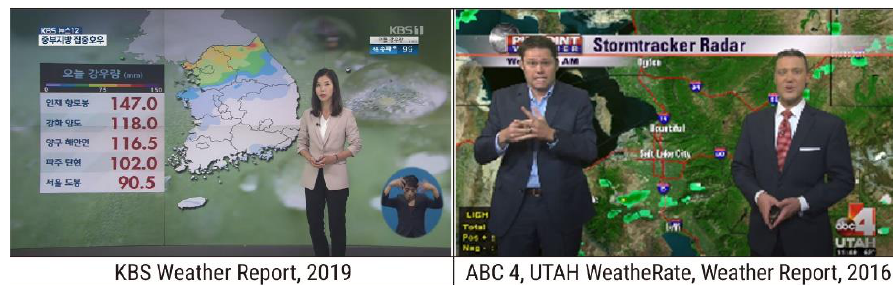
Figure 8. Examples of sign language services in weather reports.